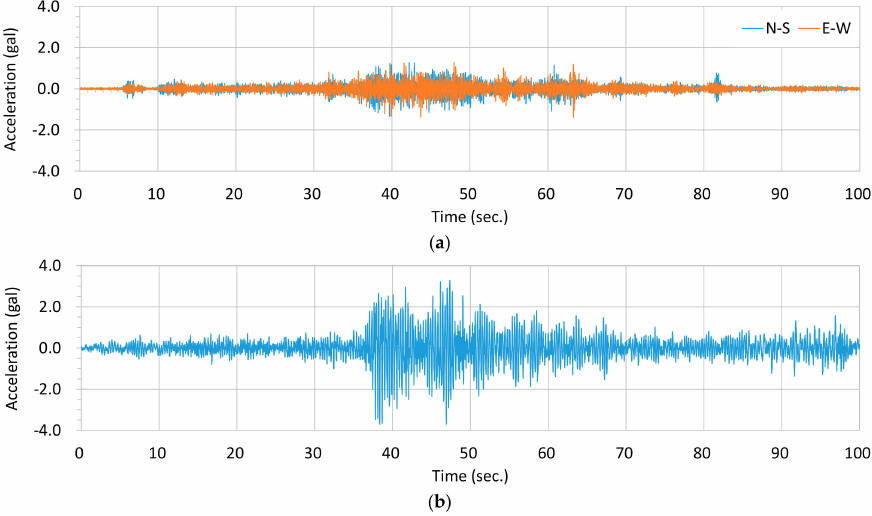
Figure 8. Measured time histories of the acceleration at the ground and top of the pylon. ( a ) Ground motion. ( b ) Top of the